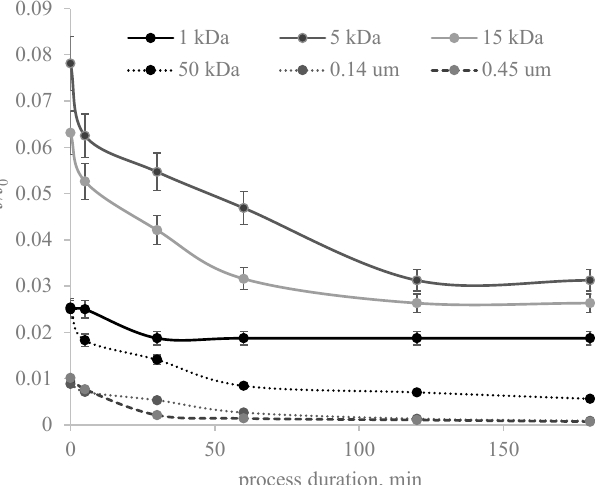
Figure 10. Influence of membrane filtration time on membrane relative permeability (TMP 0.2 MPa).